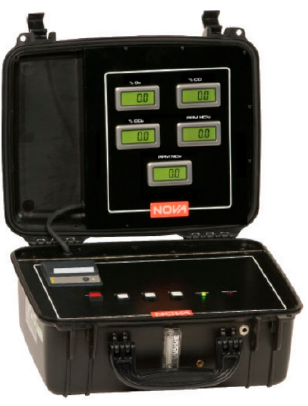
Figure 8. NOVA model 7466K used to measure the different